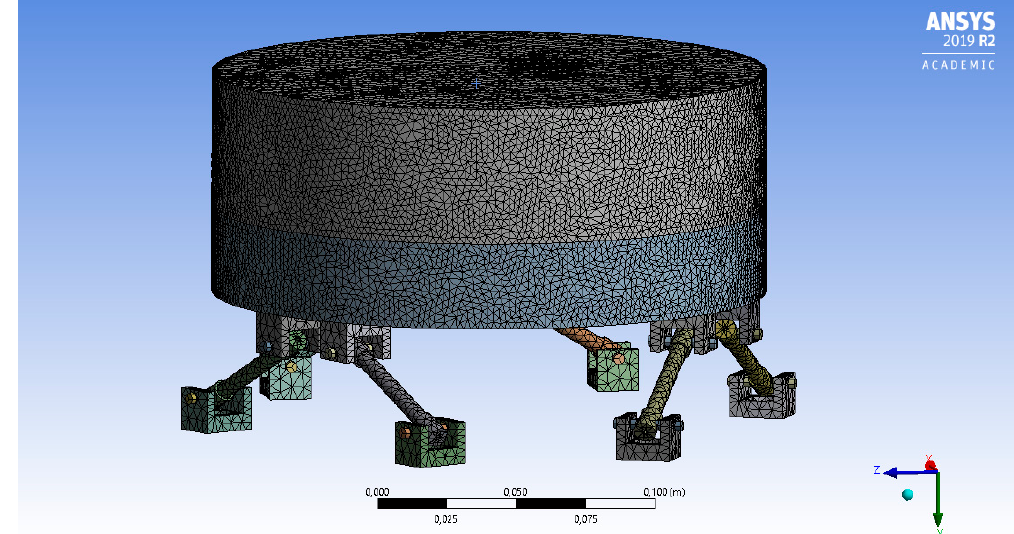
Figure 4. Simplified finite element method (FEM) model geometry and mesh.